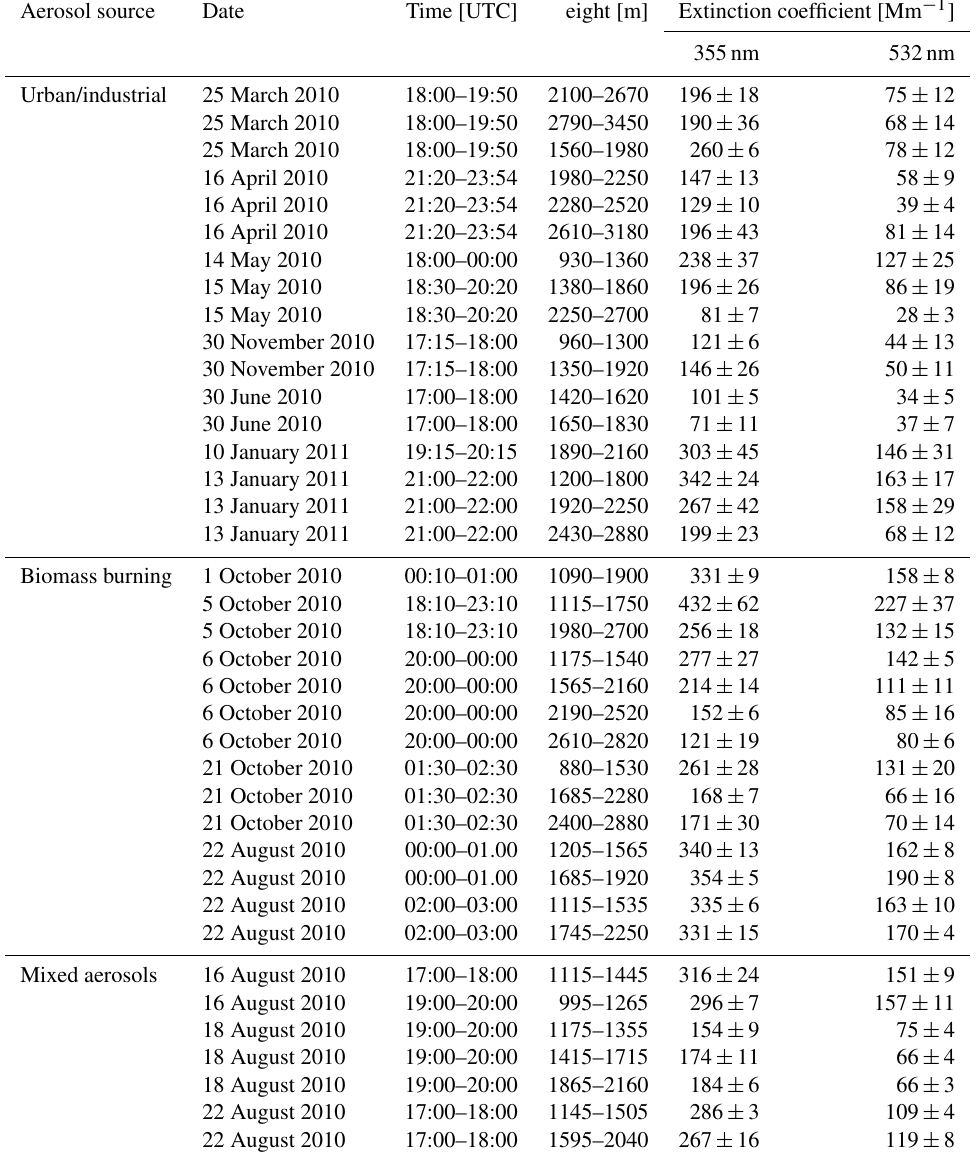
Table 1. Aerosol type, time and altitude range of aerosol layers used for optical and microphysical aerosol characterization. Aerosol source